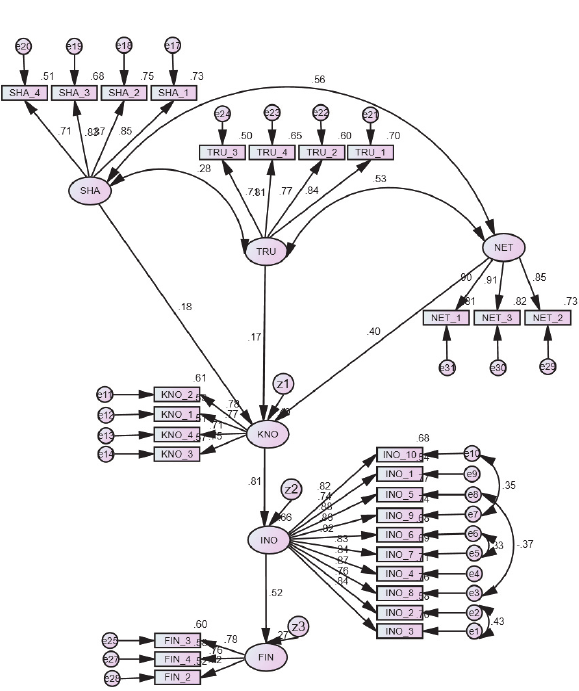
Fig. 2. The final structural equation modeling